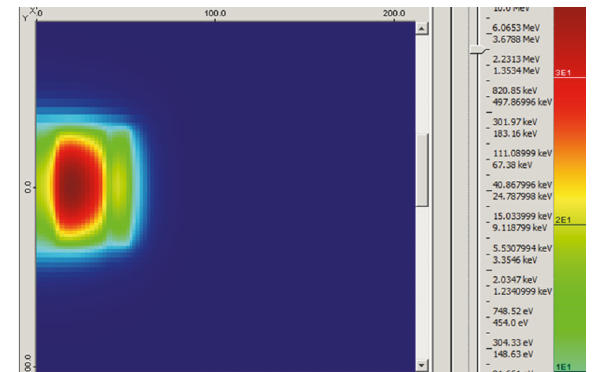
Figure 10: Distribution of the thermal neutron flux in MYRRHA calculated using the PARTISN code.